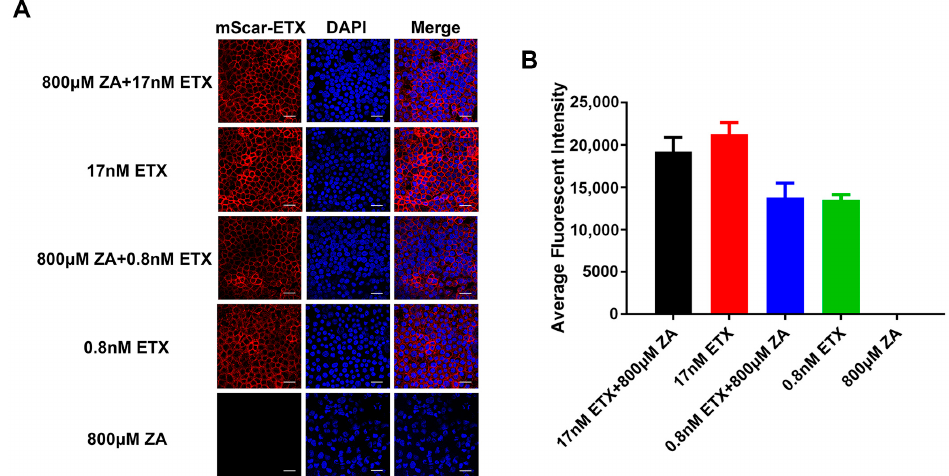
Figure 2. ZA does not inhibit binding of ETX to the membrane of MDCK cells. MDCK cells were incubated with ZA for 30 min and then treated with mScar-ETX for 1 h. ( A ) After staining with DAPI (blue), the cells were observed using confocal microscopy. Scale bar: 50 µm. ( B ) The average fluorescent intensity of ETX for different groups.